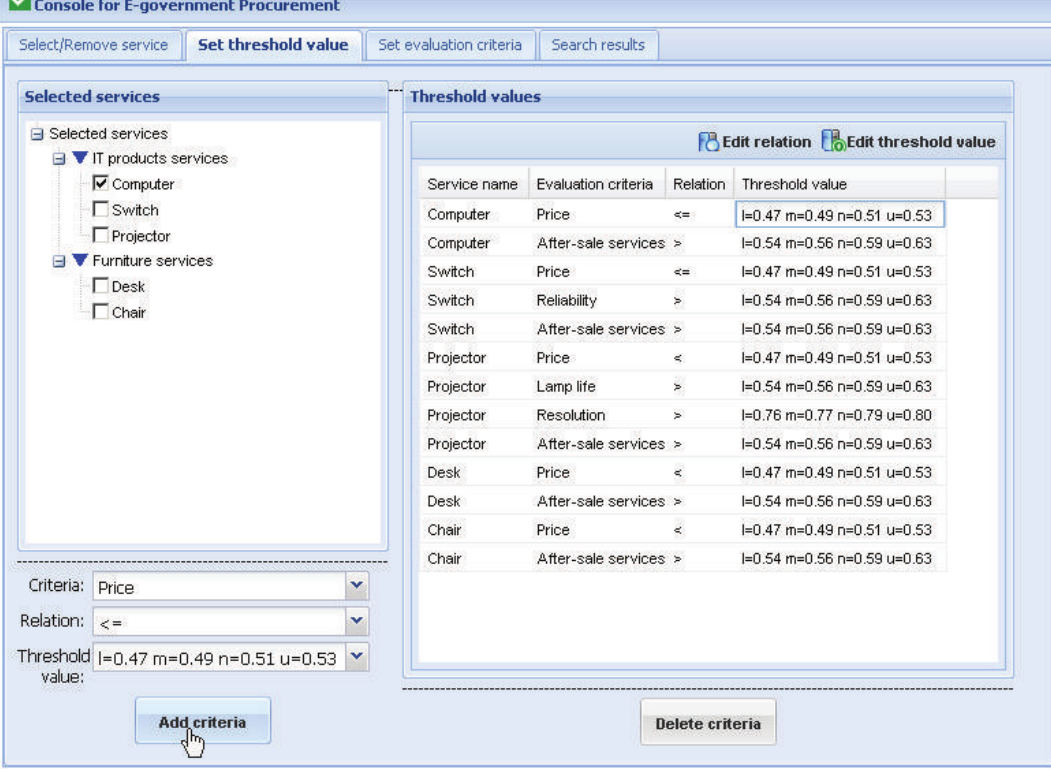
Figure 4: Graphical user interface for setting threshold values of some evaluation criteria of service